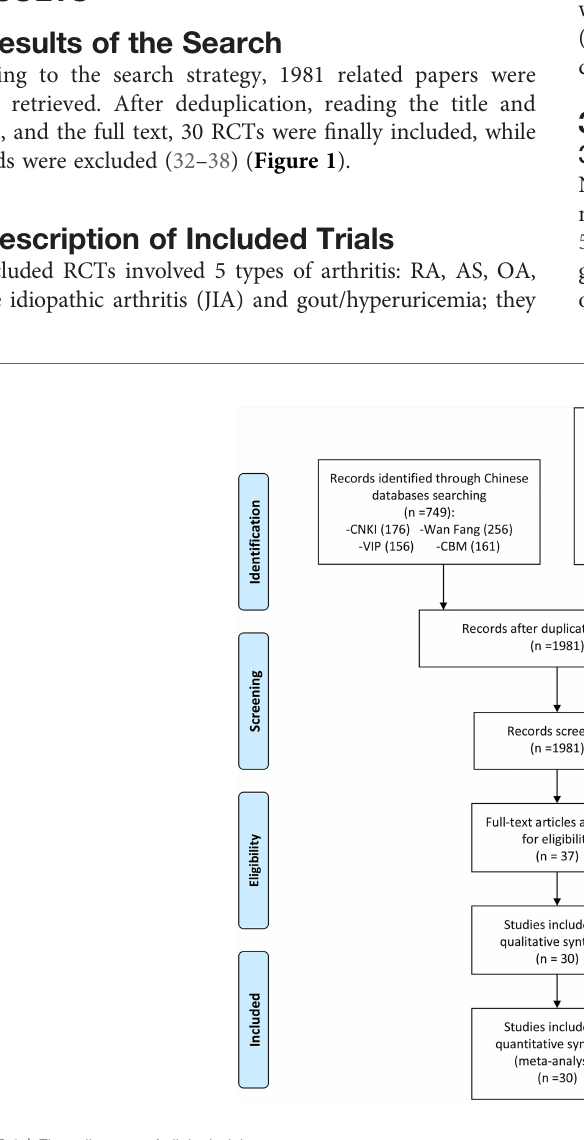
FIGURE 1 | Flow diagram of clinical